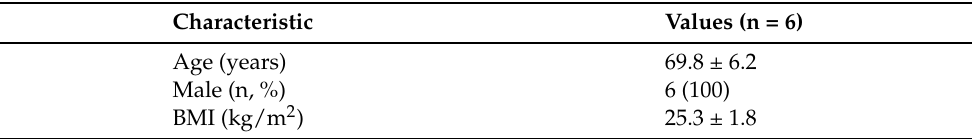
Figure 3. Cardiac patient during the EST wearing standard 12-lead ECG electrodes and the Vital Signs patch in the 5th intercostal space. Table 2. Cardiac patient characteristics.